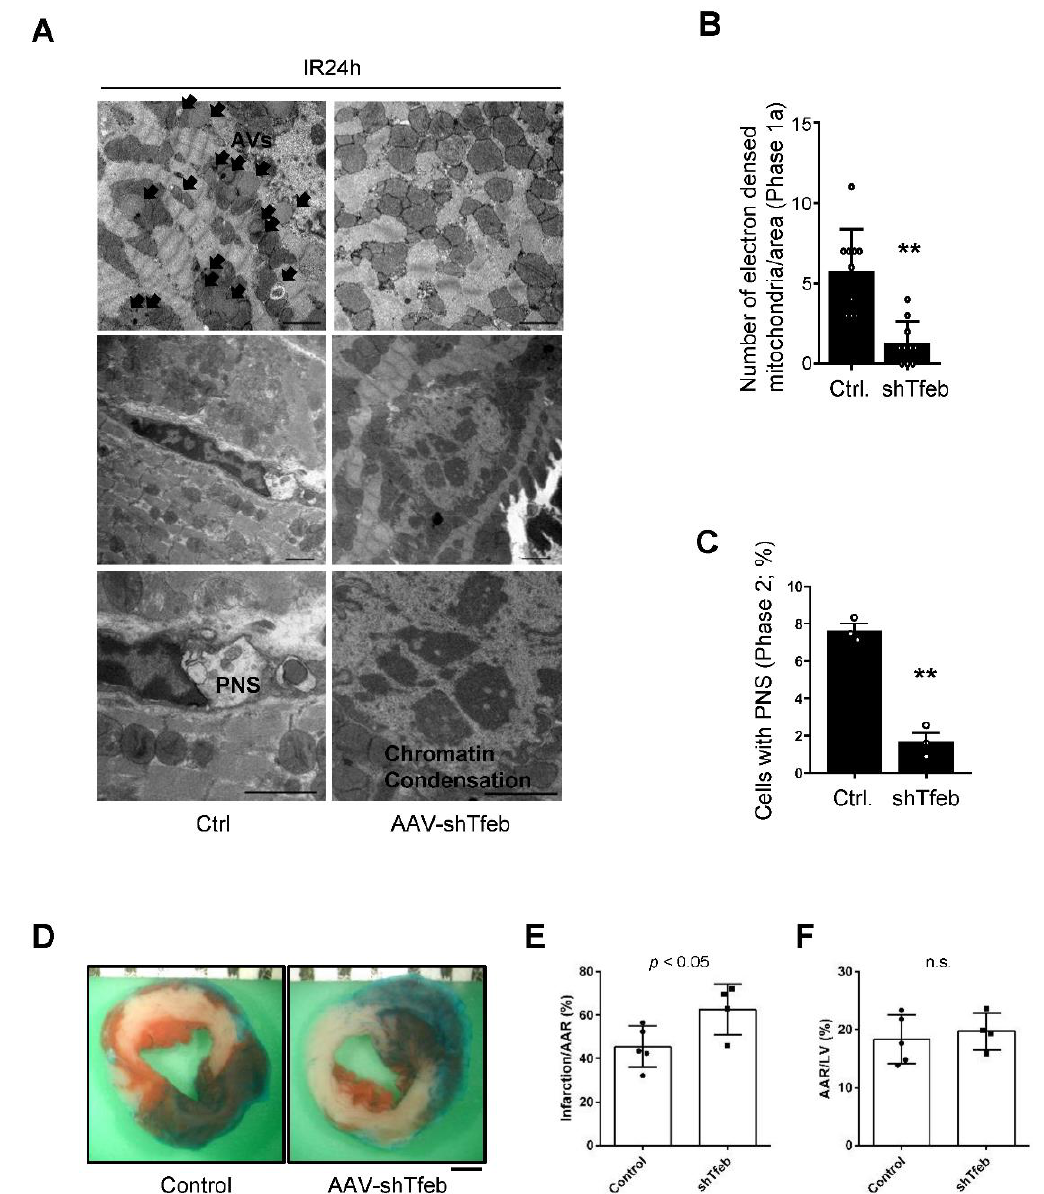
Figure 5. Downregulation of Tfeb attenuates autosis but aggravates I/R injury. ( A – F ) AAV9-shTfeb- IRES-GFP was injected into the jugular vein (1.5 × 10 12 vg per 10 g for 4 weeks). Four weeks later, mice were subject to 30 min of ischemia and 24 h of reperfusion. ( A – C ) The heart samples were subjected to electron microscopic analyses. Electron-dense mitochondria and ballooning of the perinuclear space (PNS) are indicated (scale bar = 2 µ m) ( A ). The number of electron-dense mitochondria was counted (mean values ± S.D., n = 12; ** p < 0.01 versus control with I/R 24 h) ( B ). The percentage of cells with ballooning of the PNS was calculated (mean value ± S.E., n = 3; ** p < 0.01 versus control with I/R 24 h) ( C ). Experiments were conducted using 3 mice per group. Representative images of LV myocardial sections after Alcian blue and triphenyl tetrazolium chloride (TTC) staining (scale bar = 1 mm) ( D ). The ratios of the infarction area to area at risk (AAR) ( E ) and AAR to total LV ( F ) are shown (mean value ± S.E., n = 5 (control); n = 4